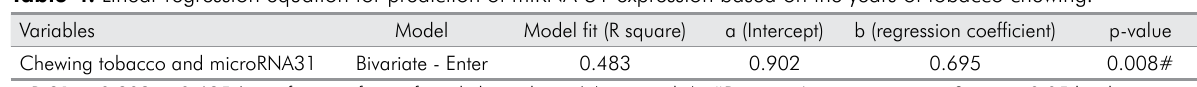
Table 4. Linear regression equation for prediction of miRNA-31 expression based on the years of tobacco chewing. Variables